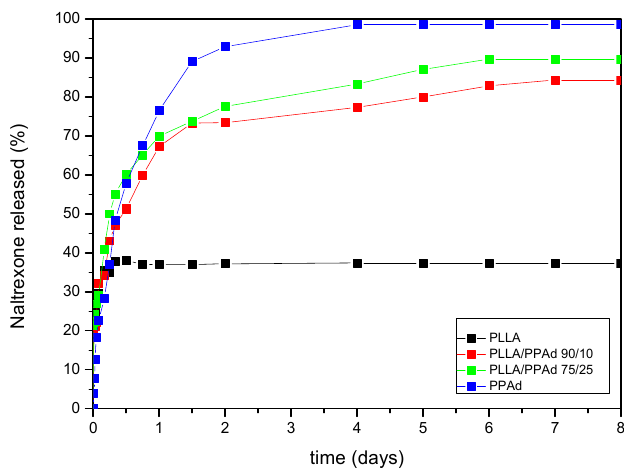
Figure 14. In vitro release profiles of neat naltrexone, along with NTX-loaded microspheres prepared from PLLA, PPAd and PLLA/PPAd copolymers.